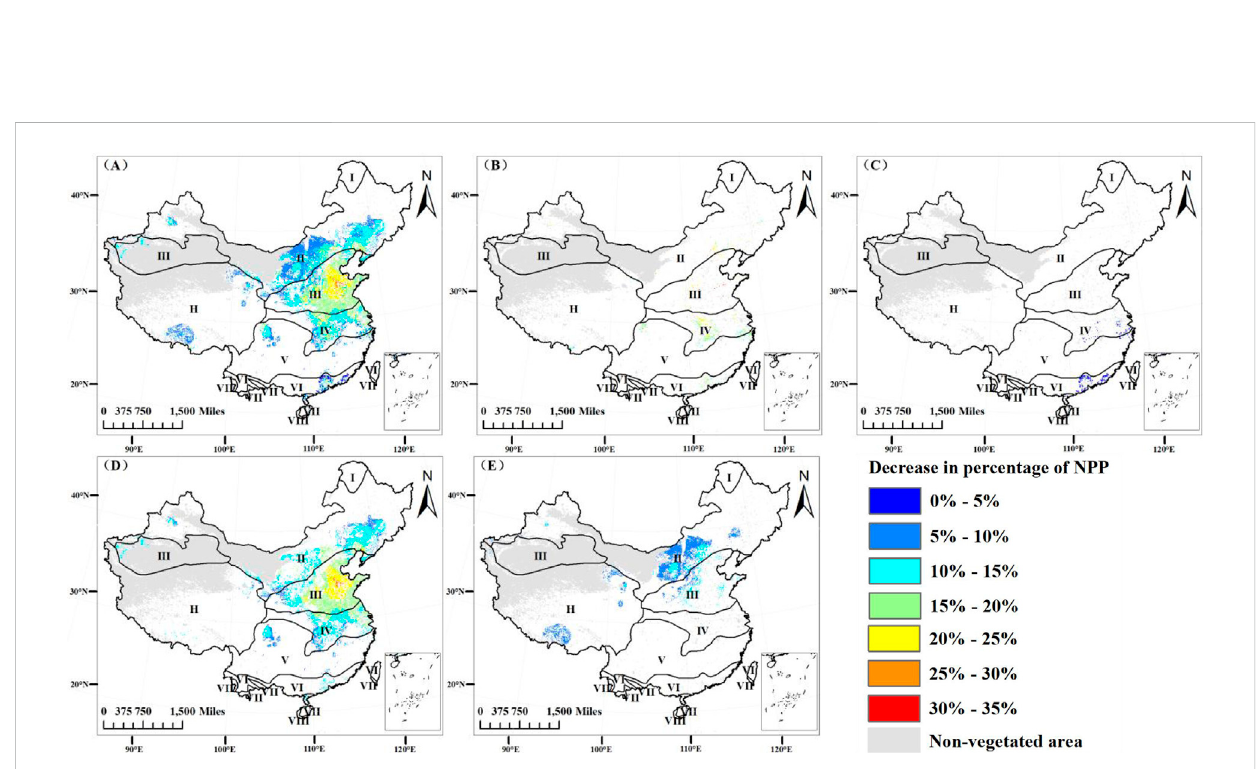
Spatialdistributionofthepercentage ofNPPdecline induced byO 3 inthefour majorterrestrialecosystemsinChina, (A) re fl ectstheoverallsituation